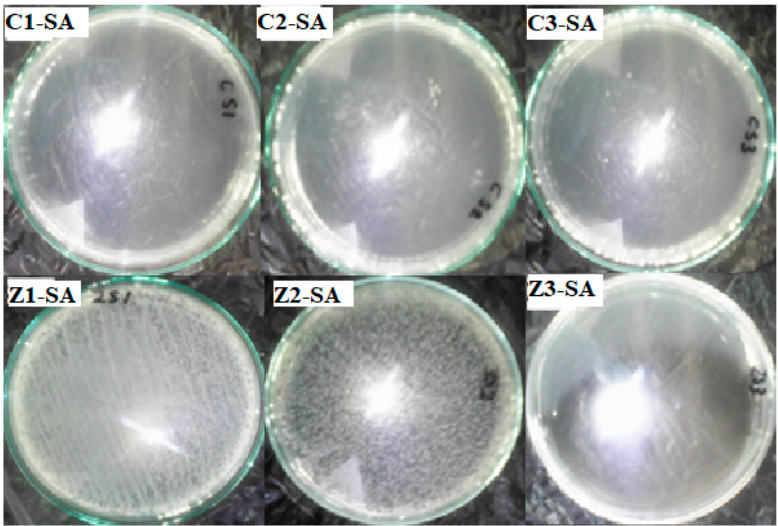
Figure 23. Antibacteria activity of clay/CuO/Ag and clay/ZnO/Ag against S. aureus in water after 24 h of incubation. C1-EC, C2-EC, C3-EC correspondingly relates to clay/CuO/Ag-1, clay/CuO/Ag-2 and clay/CuO/Ag-3 against S. aureus . Z1-EC, Z2-EC, Z3-EC correspondingly relates to clay/ZnO/Ag-1, clay/ZnO/Ag-2 and clay/ZnO/Ag-3 against S. aureus .